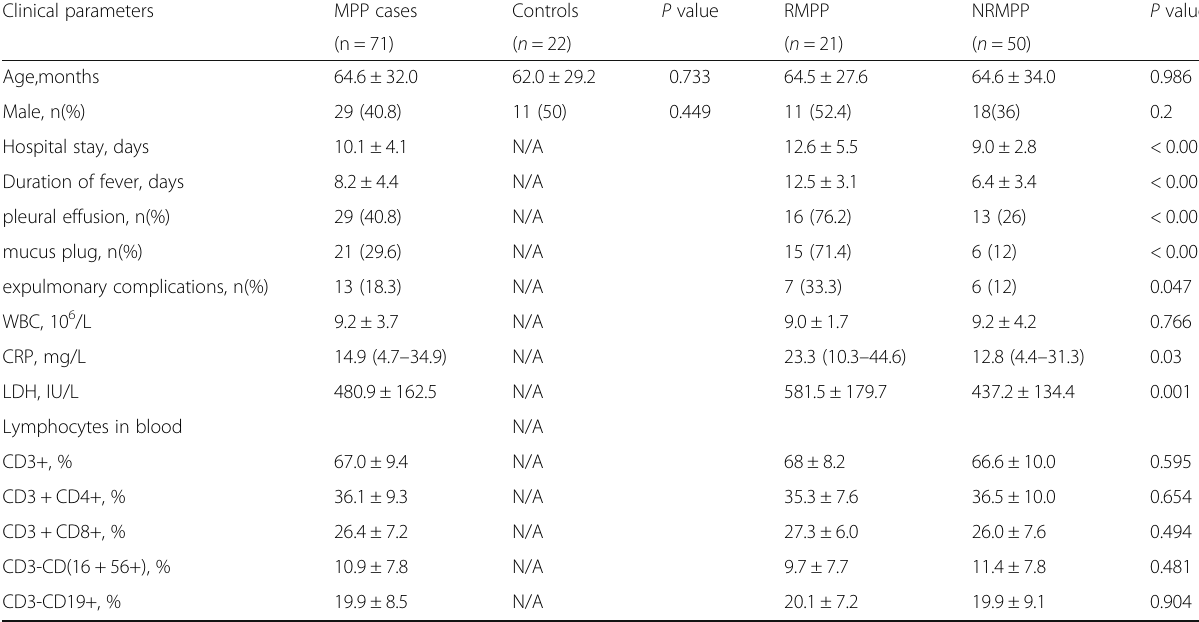
Table 1 Demographic data and clinical characteristics in children with RMPP and NRMPP Clinical